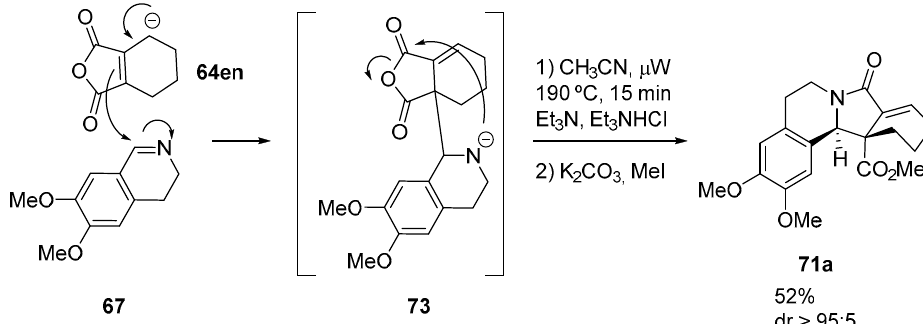
Scheme 25. A possible mechanism for the formation of polycyclic lactam 66 .